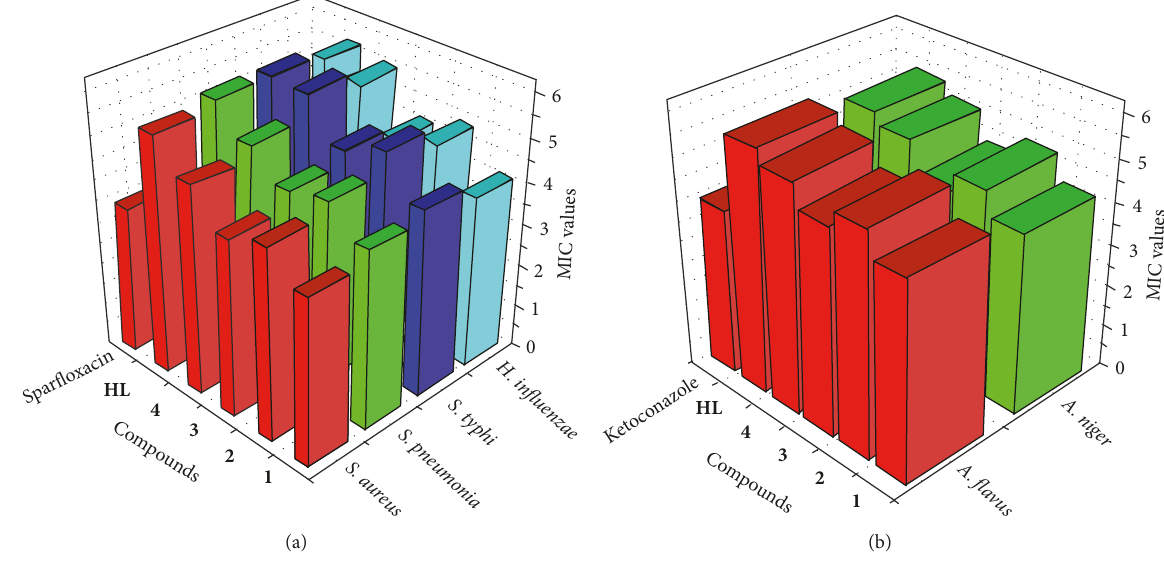
Figure 4: Minimum inhibitory concentration of ligand HL and complexes 1 – 4 (10 −2 M): (a) antibacterial; (b) antifungal.